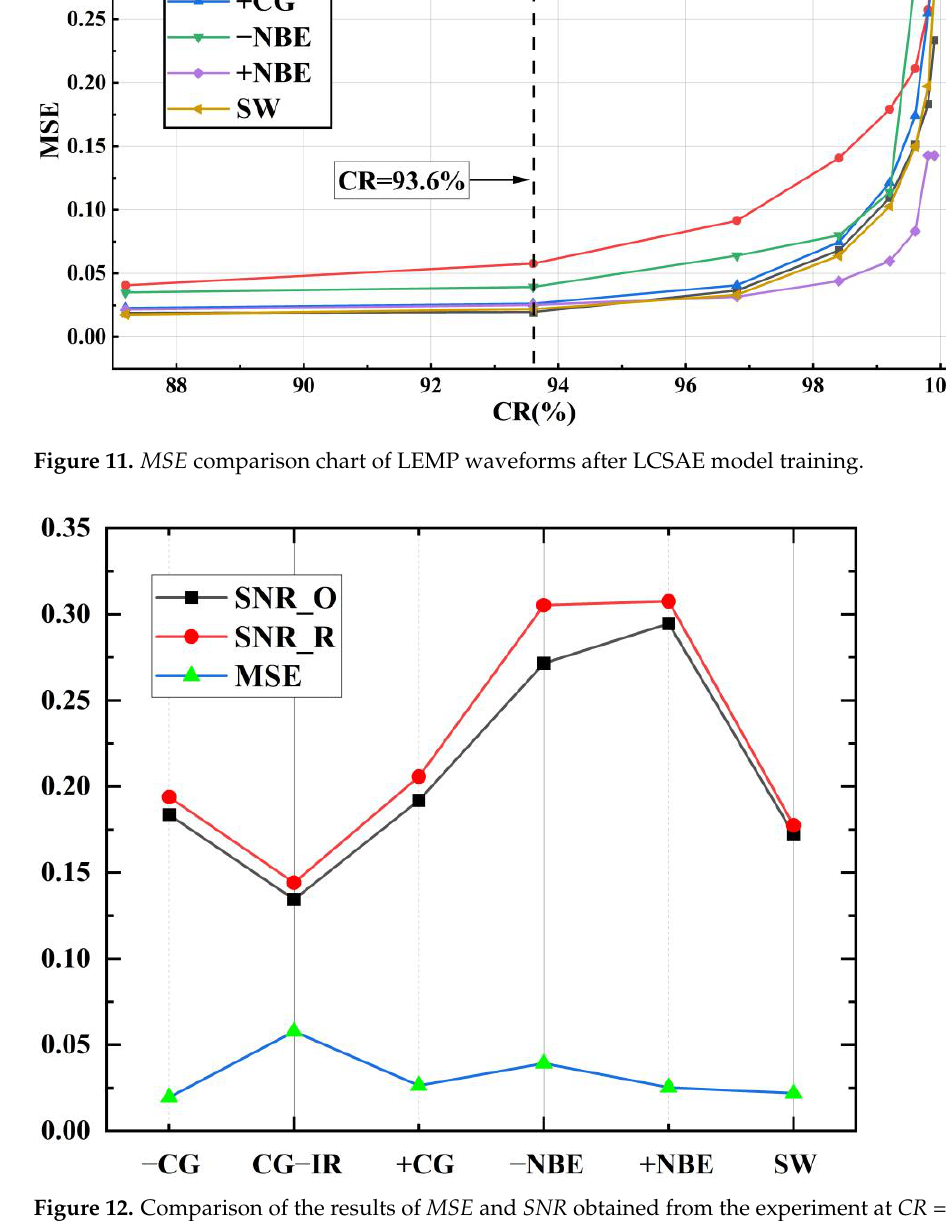
Figure 12. Comparison of the results of MSE and SNR obtained from the experiment at CR = 93.6%.